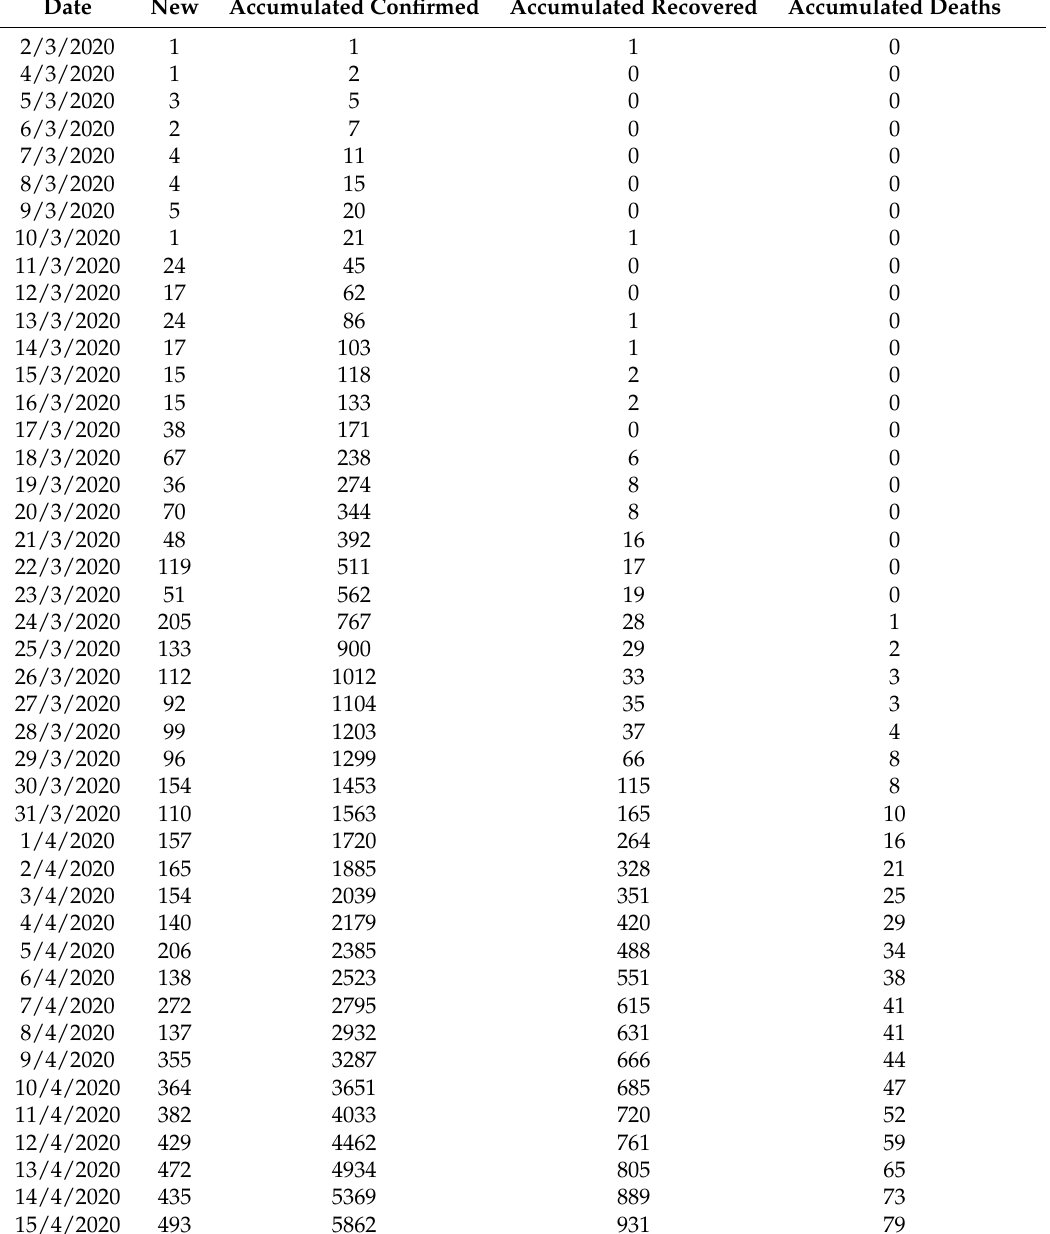
Table 1. Number of cases in Saudi Arabia from 2 March 2020 to 15 April